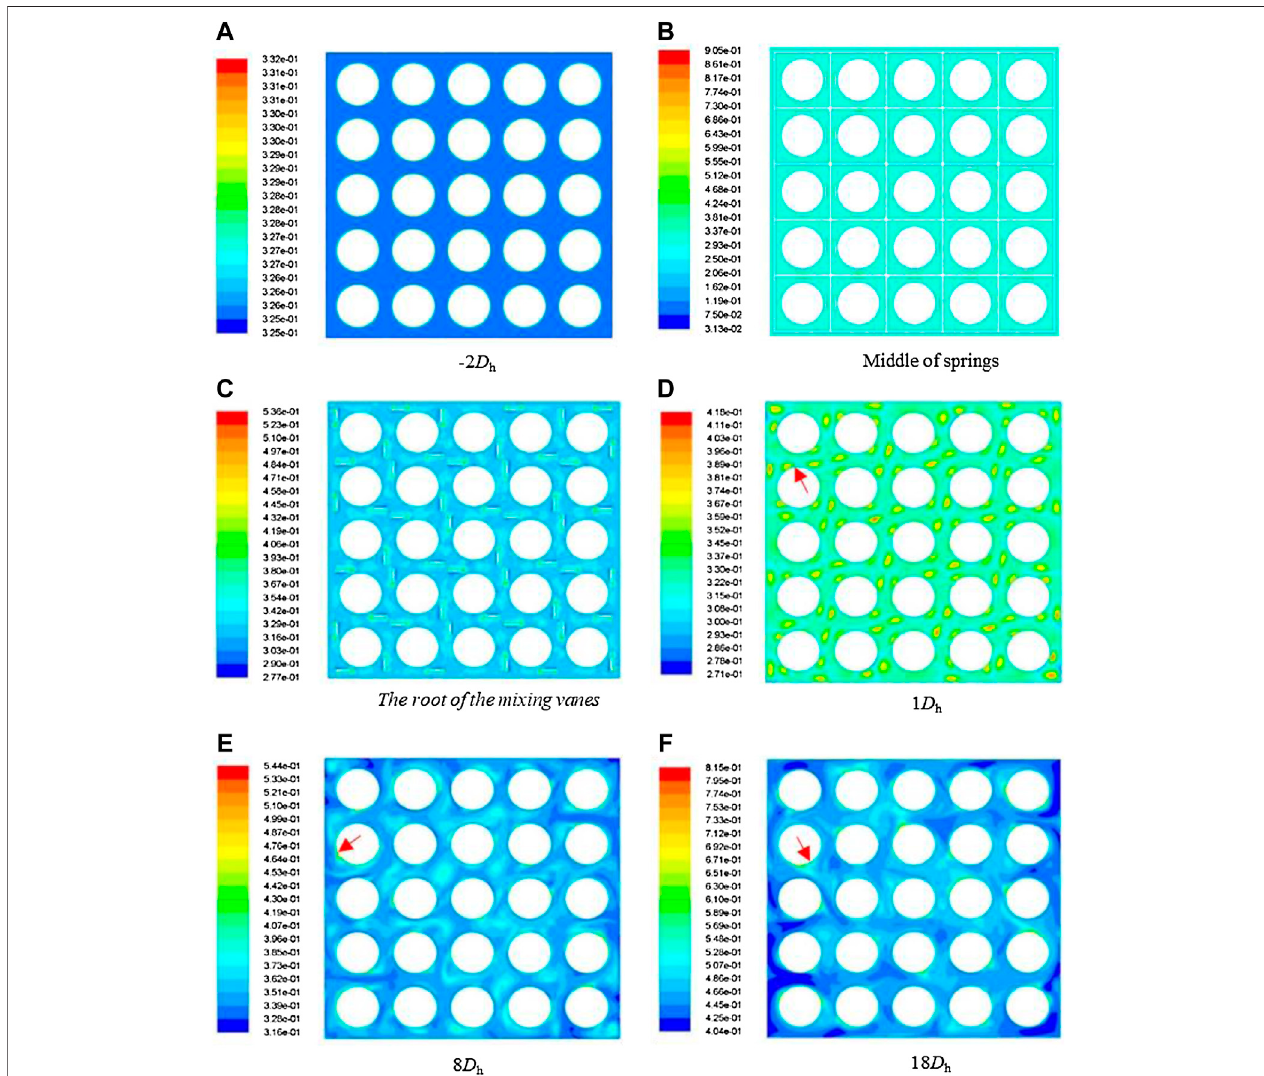
FIGURE 6 | Variations of vapor-phase distribution along axial